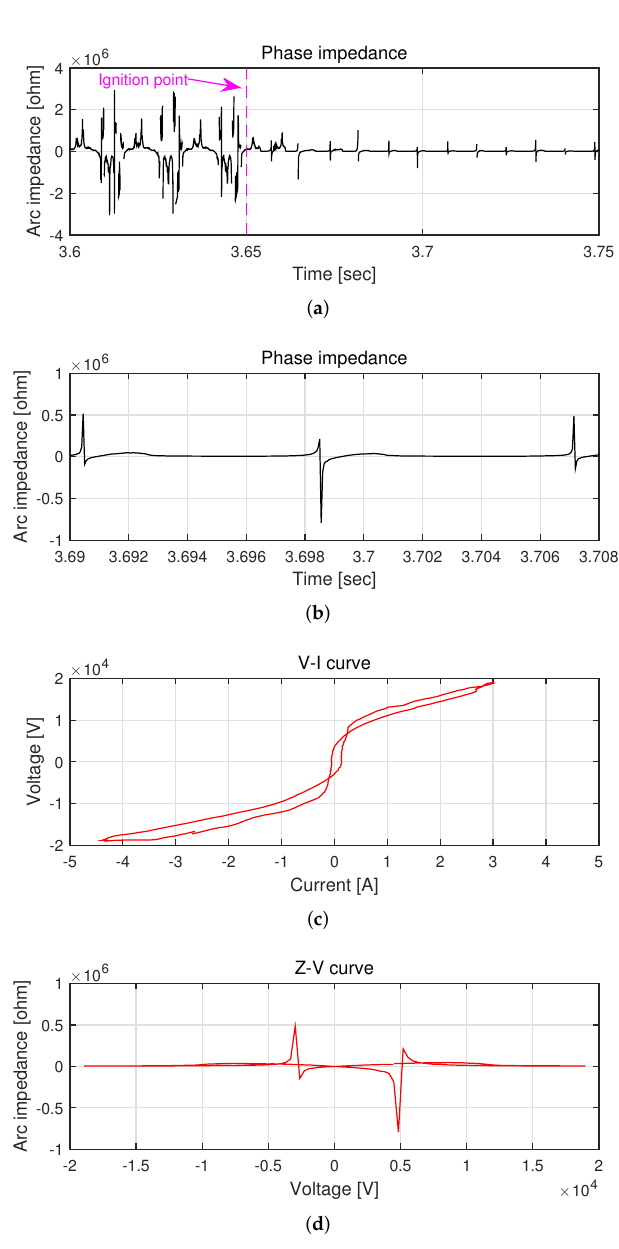
Figure 5. Experimental arc characteristics. ( a ) Phase impedance. ( b ) Phase impedance (1 cycle). ( c ) Voltage-current curve (1 cycle). ( d ) Impedance-voltage curve (1